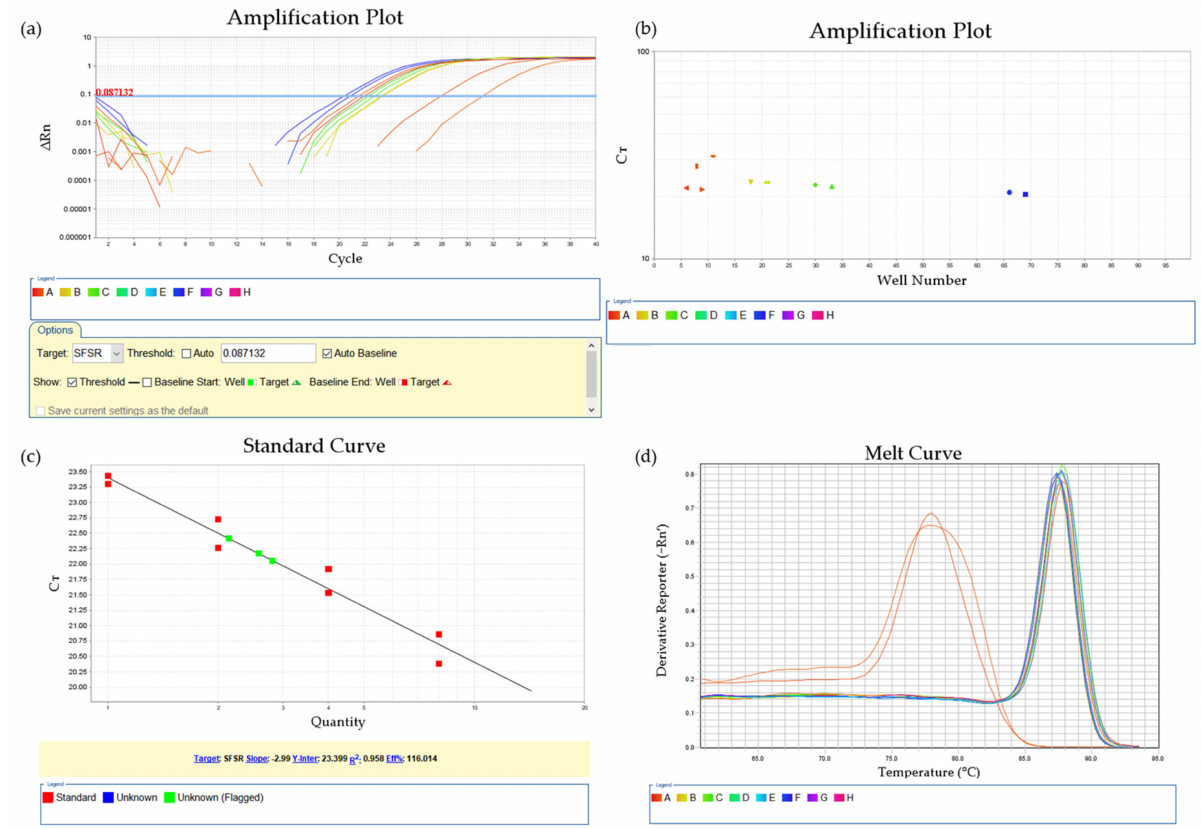
Figure 2. An example of the reported result of a real-time qPCR reaction performed on a 7500 Real-Time PCR instrument (Applied Biosystems, California, USA). This reaction plate includes two unknown samples, four standard samples, and two non-template-controls (NTCs). ( a ) Amplification curve with threshold line; ( b ) Automatically calculated Ct value for each sample; ( c ) Standard curve with amplification efficiency; ( d ) Melt curve, non-specific amplifications can be recognized based on the position of